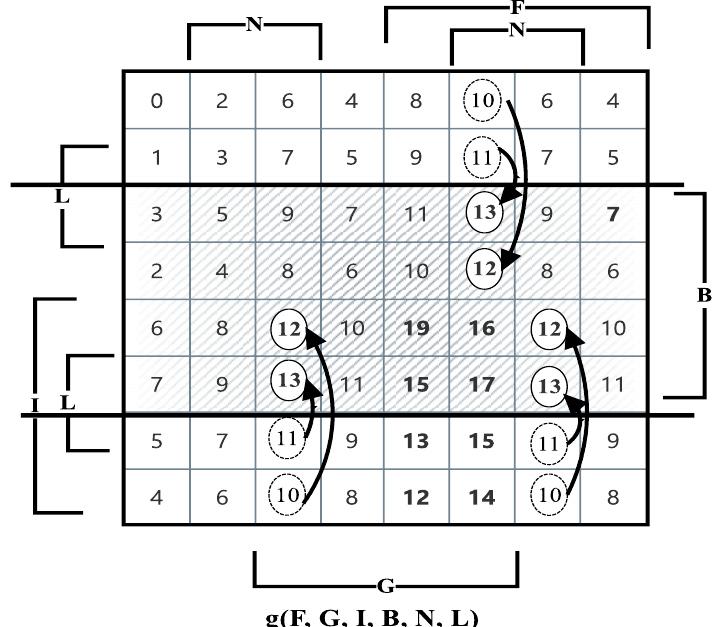
Fig. 6. A pseudo-switching function representing the sum of weighted votes. A pair of critical coalitions w. r. t. B are identified by an arrow going from a critical primitive losing coalition with a non-bold entry within a dotted ellipse to the corresponding critical primitive winning coalition (with bold entry within a